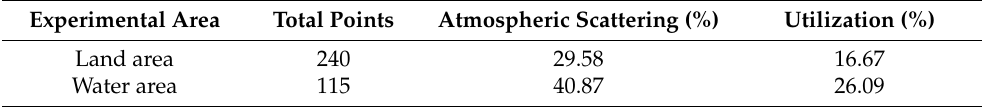
Table 12. Statistics of the results after applying scattering correction using the look-up table. Experimental Area Total Points Atmospheric Scattering (%) Land